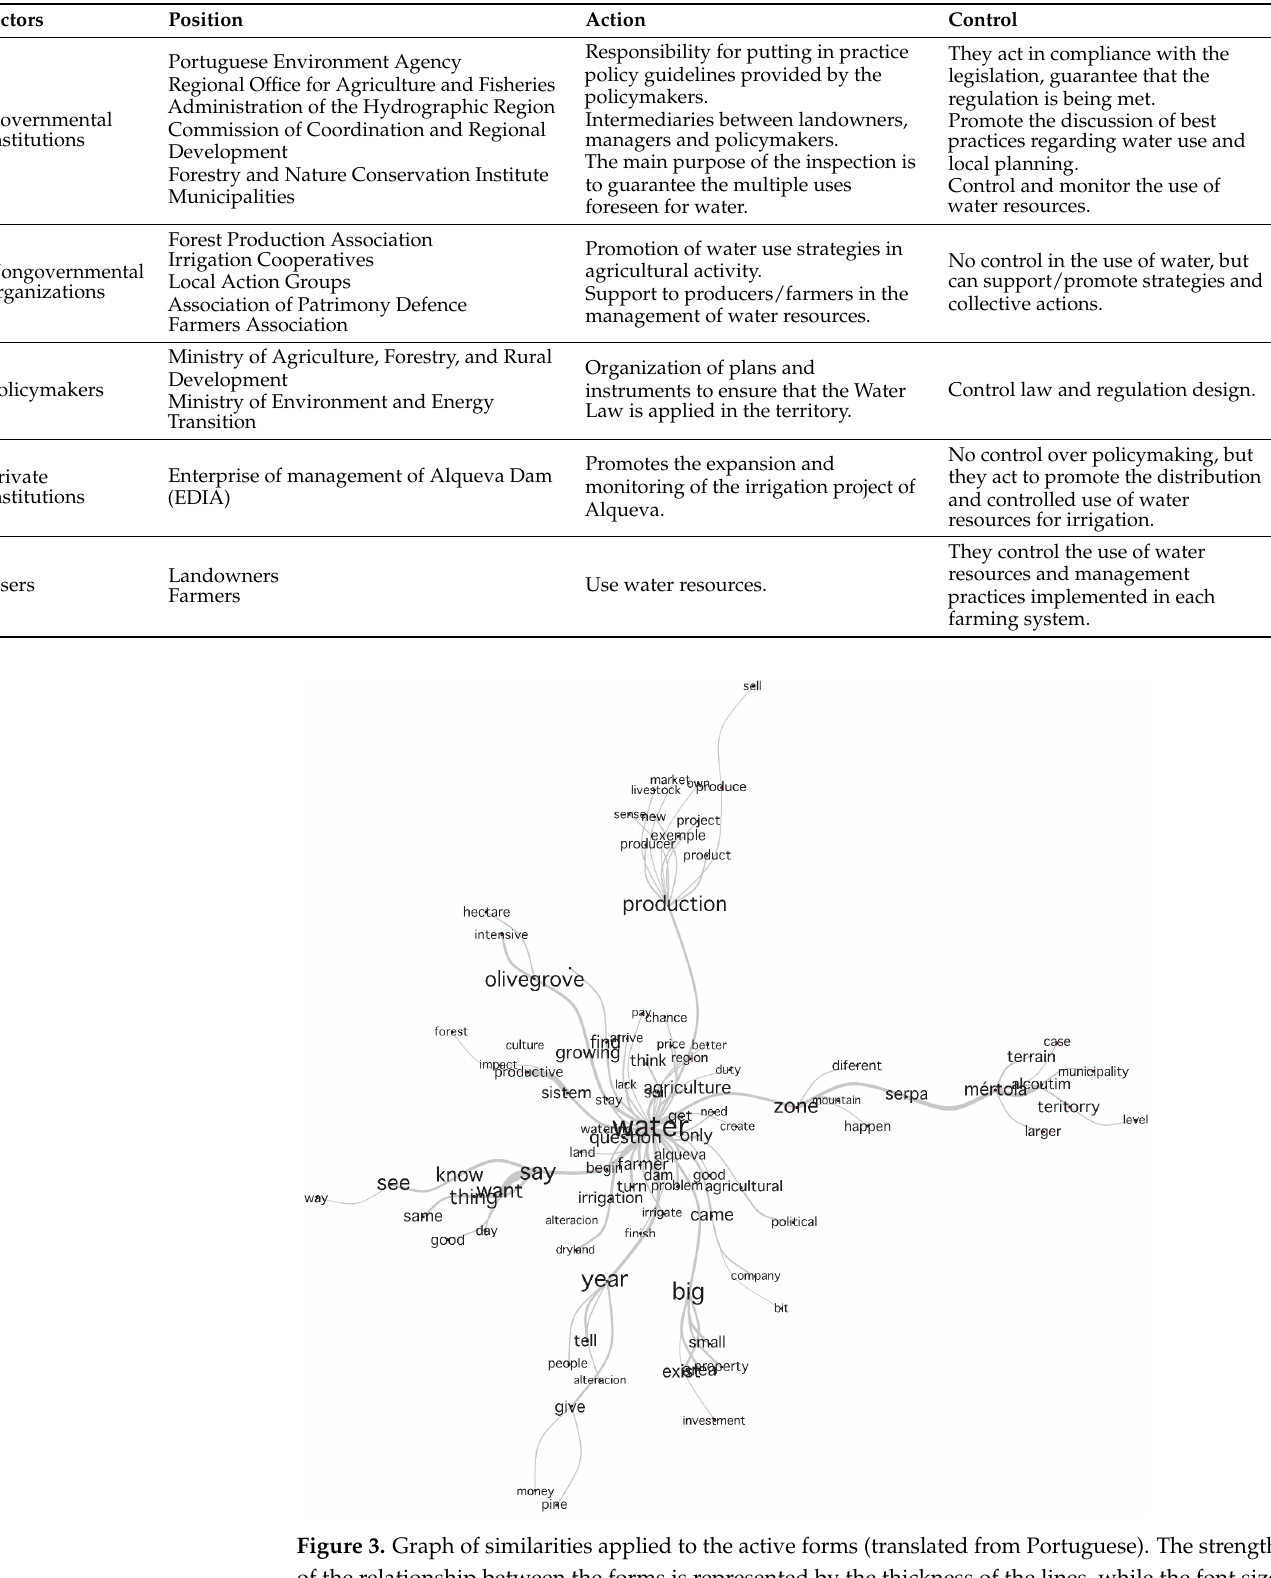
Table 2. Actors and their characteristics constructed with the data collected by the interviews.